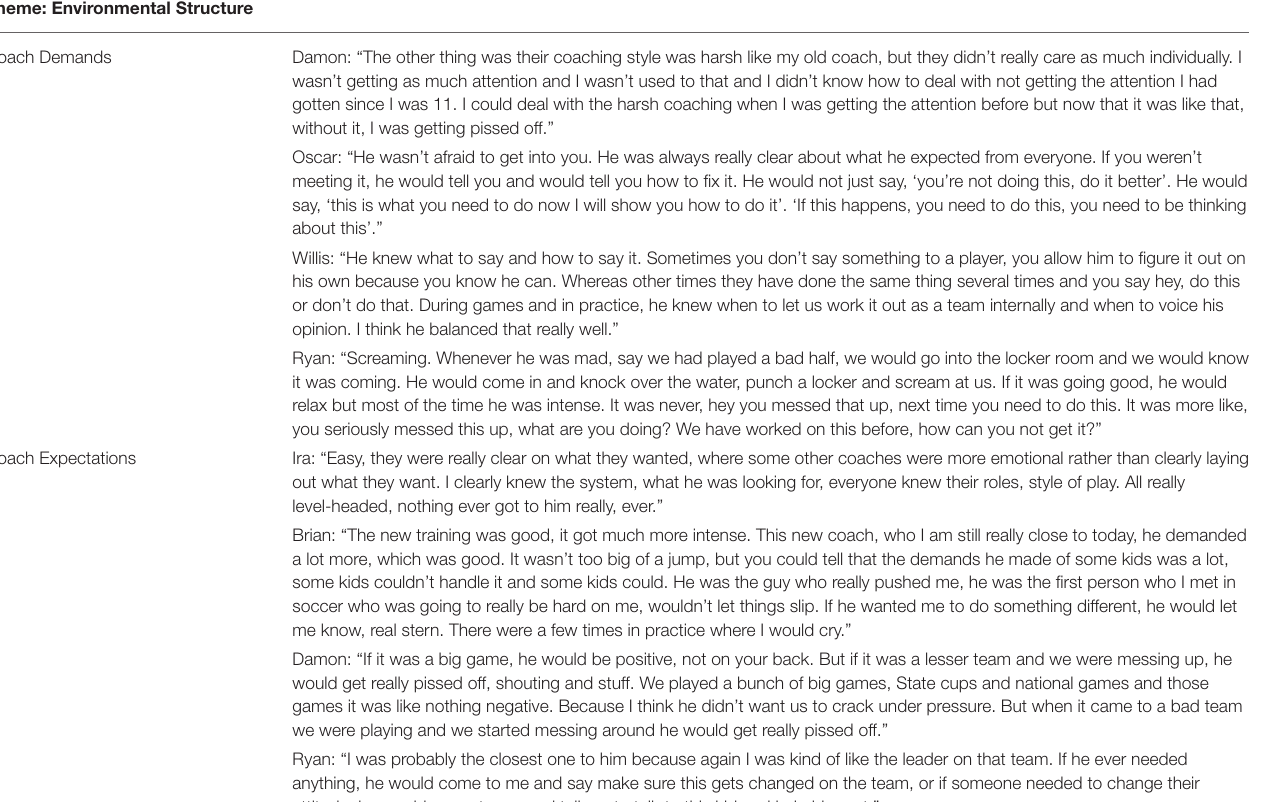
TABLE 2 | Exemplar data segments characterizing the patterns in the Environmental Structure theme. Theme: Environmental